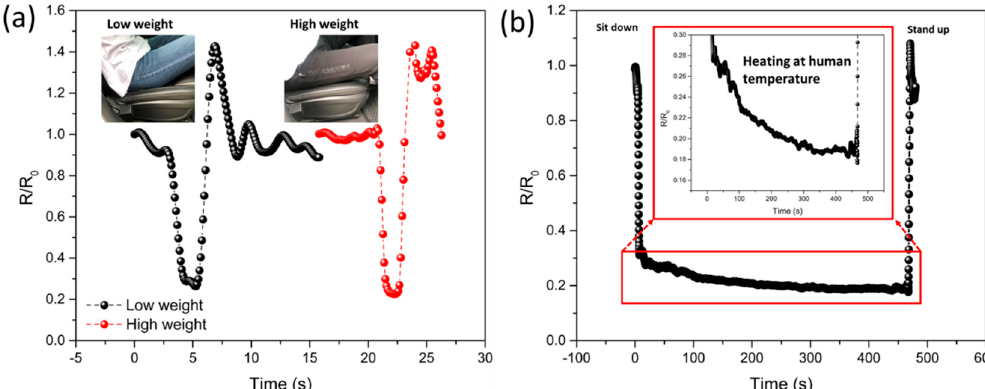
Figure 8. Application of pressure-temperature sensing abilities of multilayer sensor with modulus gradient ( a ) Real-time monitoring of low and high human mass signals getting in and out of the car seat (inset image shows results for a low mass (60 kg) and a high mass (85 kg) ( b ) Monitored real-time signals of sitting down on the seat detected by a multilayer sensor and showing heat transfer from the human body to the multilayer sensor.